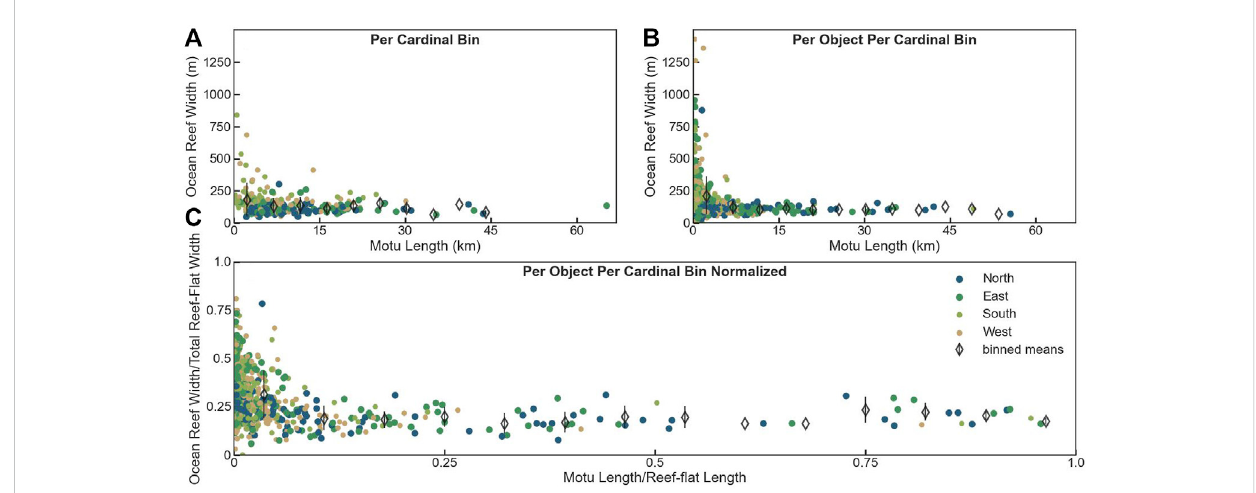
FIGURE 7 (A) . Cardinally binned reef fl at width in front of motu (ocean reef width) vs. motu length for each cardinal bin per atoll (n = 231) in French Polynesia with mean ocean reef-width (black diamonds) binned per motu length with standard deviation. (B) Reef fl at width in front of motu (ocean reef width) vs. motu length for each motu (n = 832)in French Polynesia classi fi ed by cardinal position on the atoll with mean ocean reef-width (black diamonds)binned per motu length with standard deviation. (C) Reef fl at width in front of the motu normalized by the width of the reef fl at the motu is on vs. the motu length normalized by the length of the reef fl at the motu is on classi fi ed by cardinal position on the atoll for every motu (n = 836) with mean normalized ocean reef-width (black diamonds) binned per normalized motu length with standard